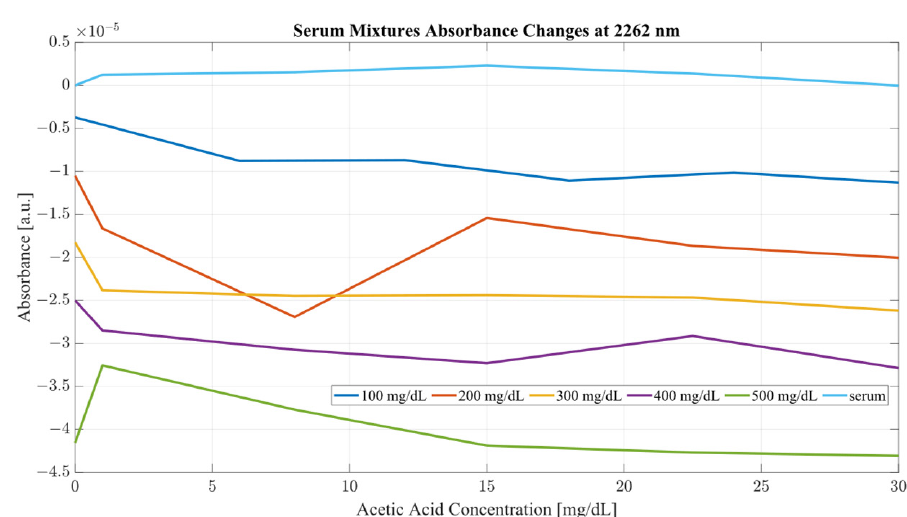
Figure 7. Water mixture absorbance changes at 2302 nm.